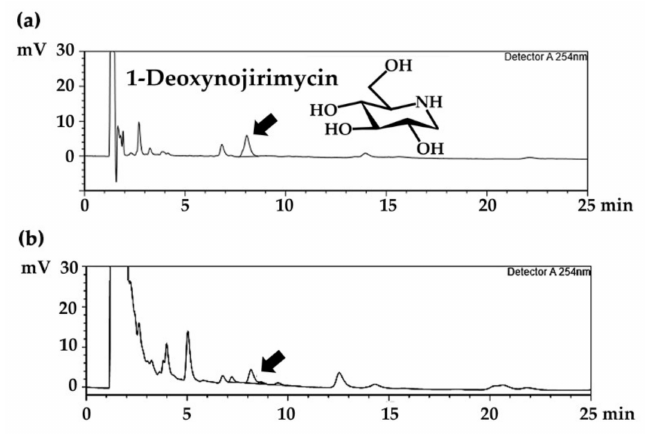
Figure 2. HPLC chromatograms of ( a ) 1-deoxynojirimycin and ( b ) M. alba leaf extract.